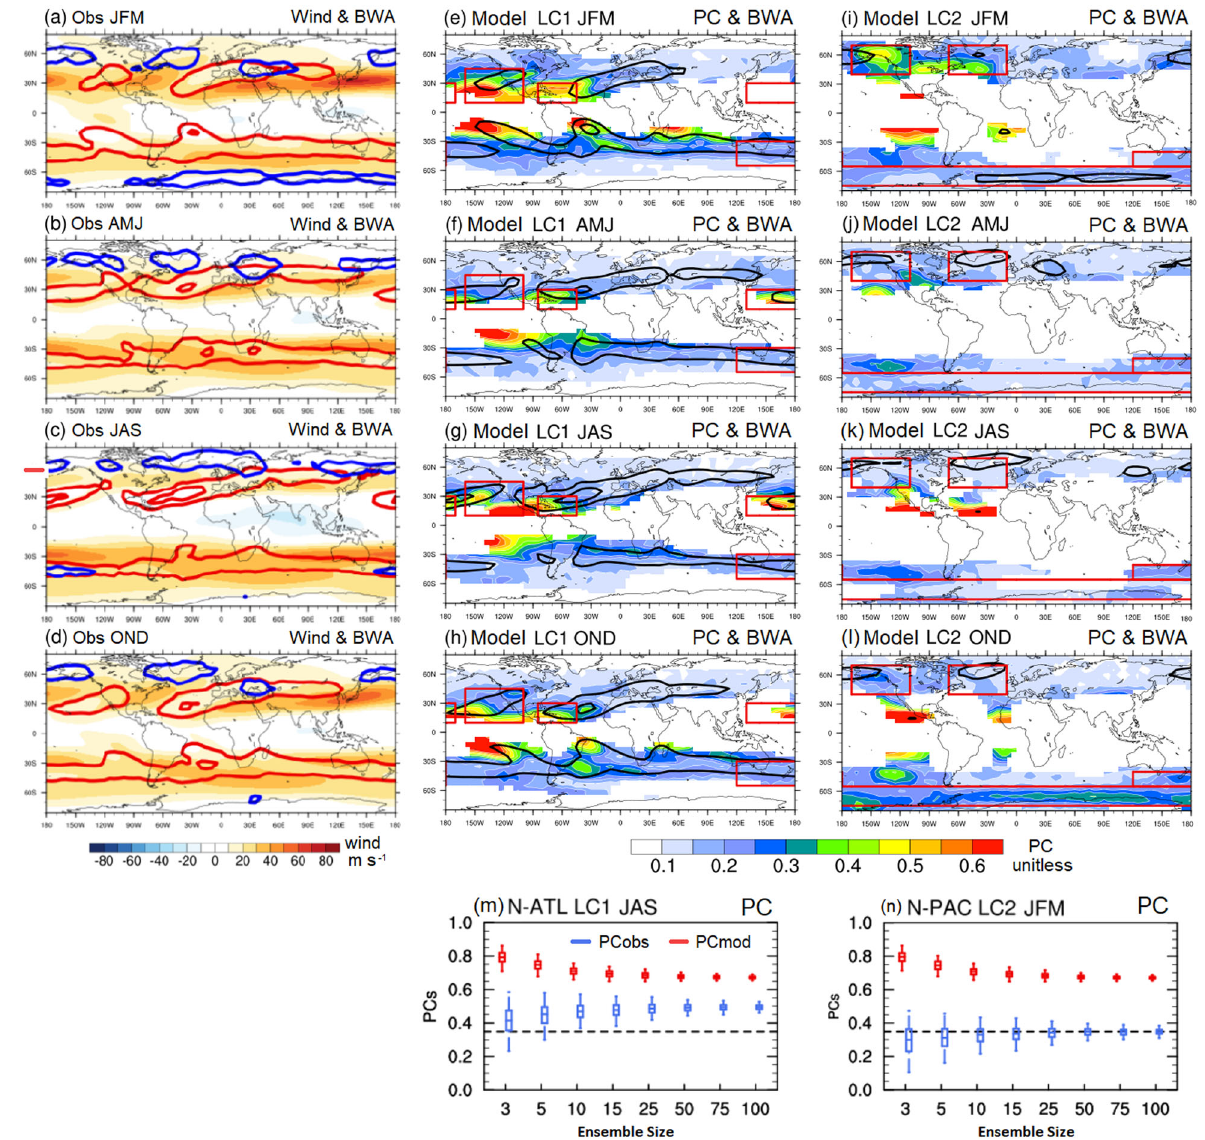
Fig. 2 Climatology and predictability metrics of baroclinic waves in d4PDF simulation. a – d Climatology of 200-hPa zonal wind (m s − 1 ; shading) and the observed spatial distributions of LC1 (red contour) and LC2 (blue contour) events during 1979 – 2010. The contoured distributions are BWA as represented by the counts of PV features in gridded boxes (see “ Classi fi cation of baroclinic wave life cycle ” ). These counts are sums during a January – March, b April – June, c July – September, and d October – December. The contours levels are 4 and 10 events season − 1 , and the latter only shows up with LC1 events as small and enclosed regions. e – h Climatology (black contours) and predictable components (PCs from Method e ) (unitless; shading) of LC1 events as simulated by the SST-forced experiments. i , l Same as ( e – h ), but for LC2 events. The climatology of BWA in ( e – l ) shares the same contour levels as ( a – d ). The PC values are omitted from shading in regions with low BWA (<0.5 events season − 1 ). The red boxes indicate the individual regions examined separately later. m PCs of the July – September event count of N-ATL LC1 (10 – 30°N, 45 – 85°W) as a function of the ensemble size. Red shows the model PCs estimated with the SST-forced large ensemble, and blue shows the correlation skills (i.e., PC obs ) of the same simulation. The boxplots indicate 2.5th, 25th, 50th, 75th, and 97.5th percentiles of metrics, determined from the bootstrapping technique. The black dashed line indicates the 5% signi fi cance level of the correlation coef fi cient. n is the same as ( m ), but for the PCs of the January – March event count of N-PAC LC2 (40 – 70°N, 110 –